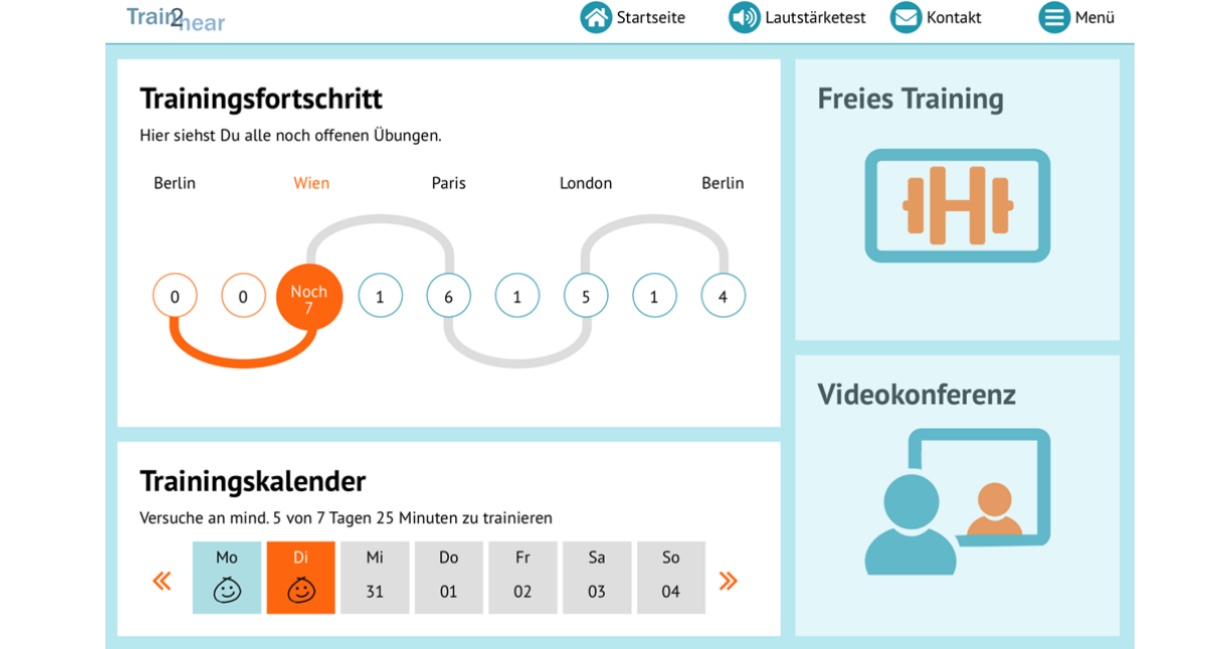
Figure 6. Overview of the cochlear implant user's training